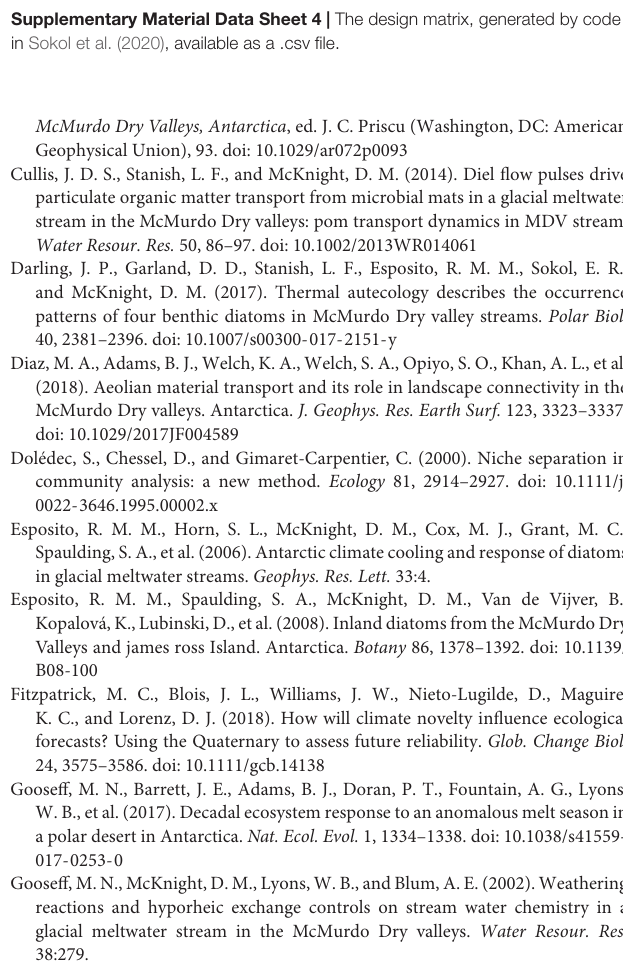
Supplementary Material Table 1 | Description of simulation initial conditions derived from empirical